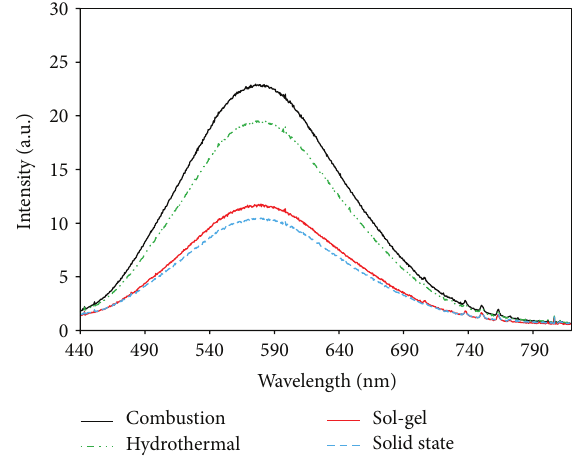
Figure 6: Effects of synthesis methods on the PL emission intensity of Zn 3 V 2 O 8